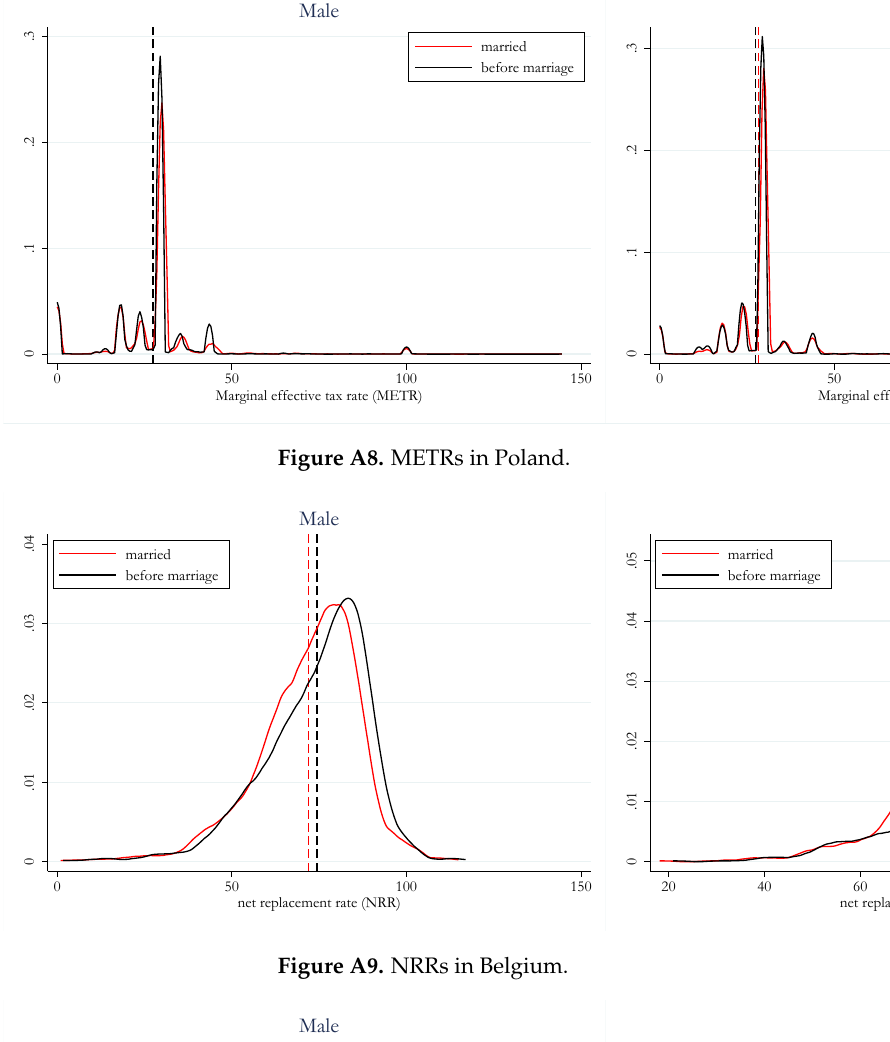
Figure A9. NRRs in Belgium.